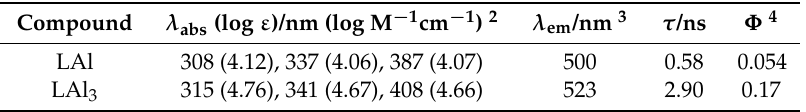
Table 1. Photophysical properties of Al salophen complexes 1 .